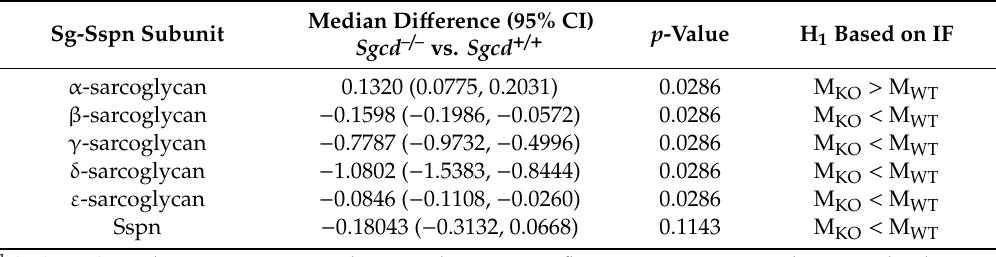
Table 2. Sspn was not significantly di ff erent between genotype groups. Table 2. Differences in normalized protein expression of three-month-old Sgcd − / − and Sgcd +/+ mice ( n = 12). 1 Median Di ff erence (95% CI) Sg-Sspn Subunit Sgcd – / – vs. Sgcd